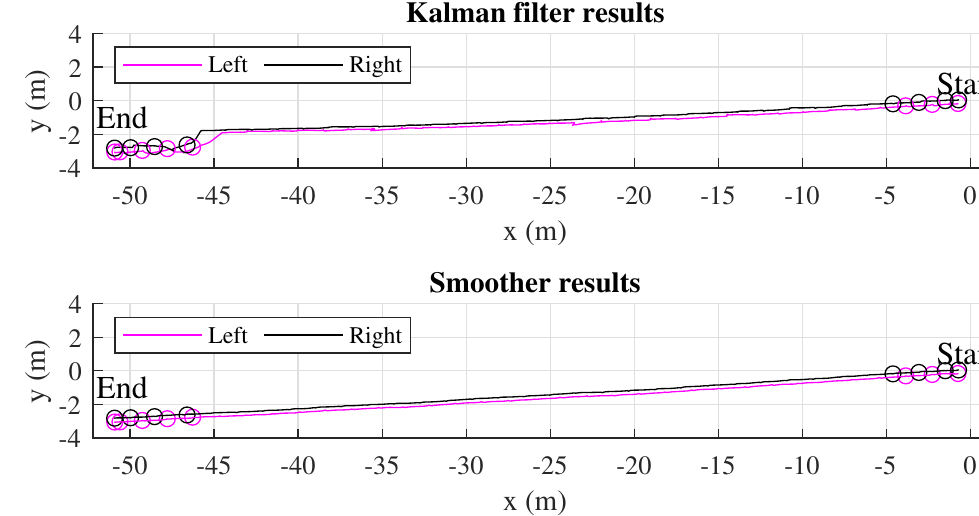
Figure 12. An example of an estimation of 50 m walking trajectories from the Kalman filter and the smoother algorithm. The circles represent the estimated LiDAR-based foot positions in the stance